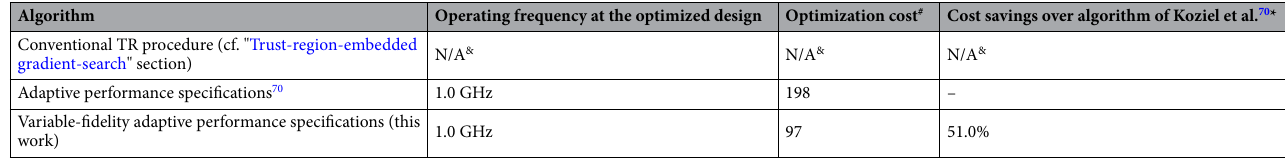
Table 3. Optimization results for Circuit I. $ Objective function computed as in (2). # Cost expresses in equivalent number of high-fidelity EM simulations. & The algorithm failed to identify a satisfactory design, in particular, align the circuit operating frequency with the target. *Relative computational savings in percent w.r.t. the algorithm of Koziel et al. 70 .